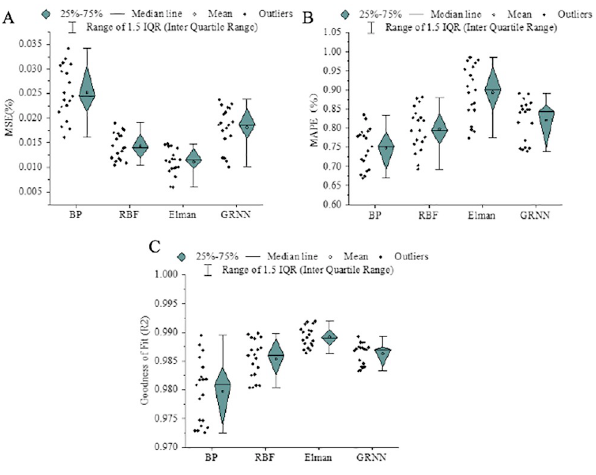
Fig 8. Prediction performance evaluation of different carbon emission models.